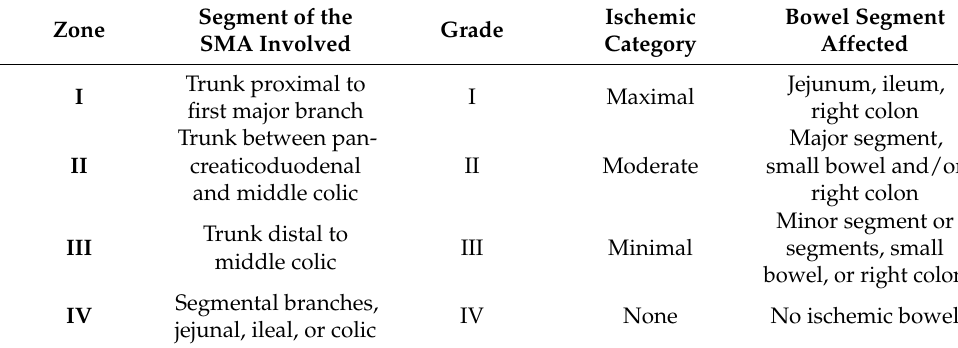
Figure 5. Classic anatomical relationship between the aorta, left renal vein, and SMA. RRA: right renal artery; RRV = right renal vein; IVC: inferior vena cava; SMA: superior mesenteric artery; LRV: left renal vein; IPA: inferior phrenic artery; PA: phrenic artery. Table 2. Fullen Anatomic Classification of Superior Mesenteric Artery